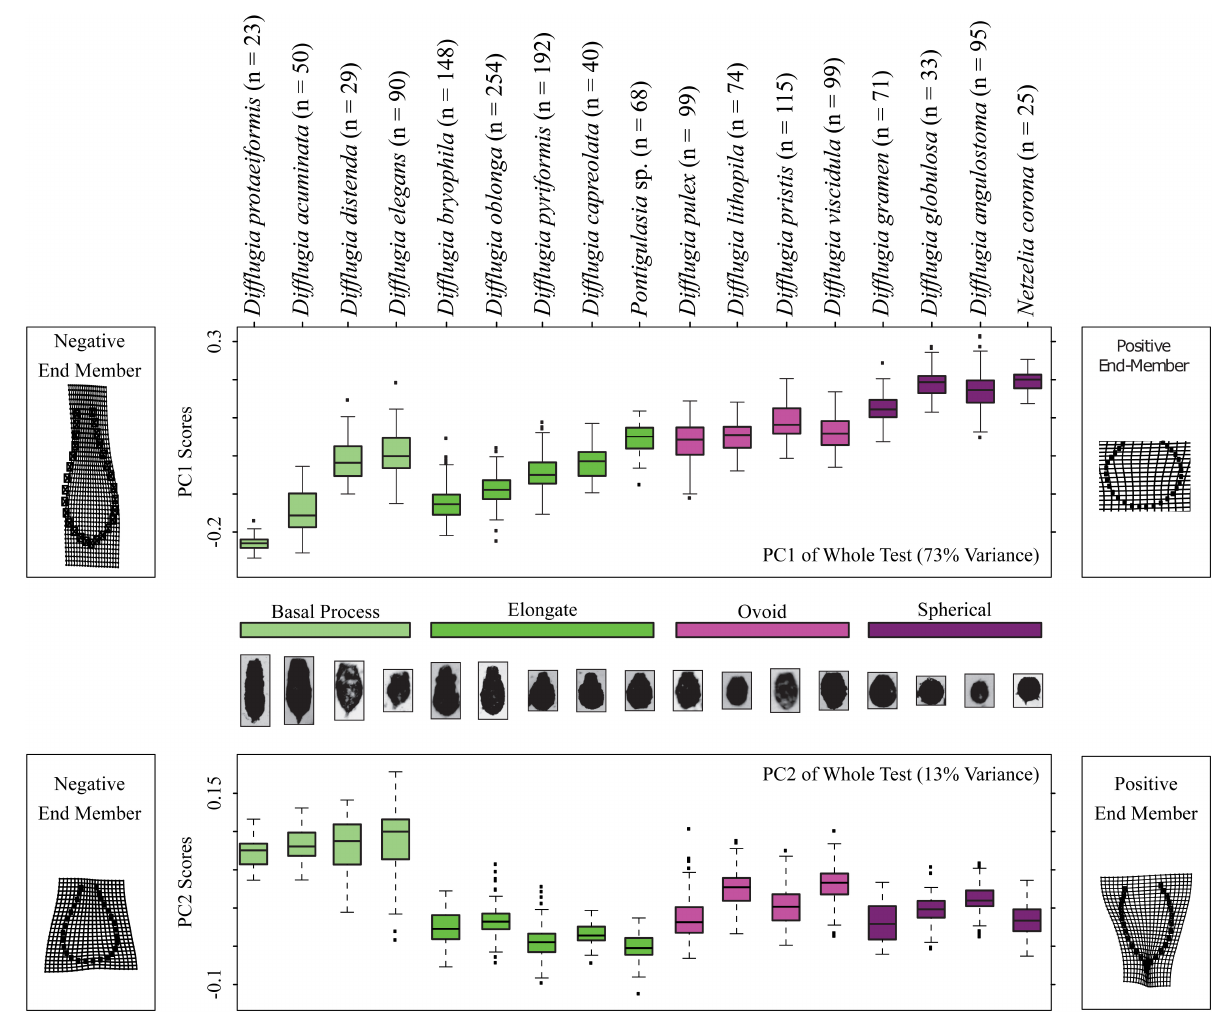
FIGURE 3 | Boxplots showing the distributions of Procrustes Principal Component Analysis axis 1 and 2 scores, top and bottom panels, respectively, for each taxon and color coded by shape group. The models on the left and right sides of the diagrams illustrate shape end-members on deformation grids representing the deviation in shape from the mean shape. The number of specimens analyzed for each taxon is